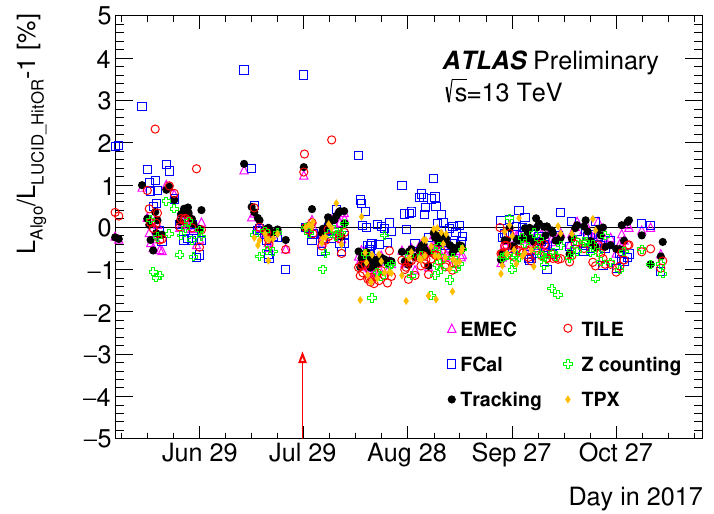
Figure 3. Fractional difference in the run-integrated luminosity between the preferred LUCID algorithm and other detectors as defined in the introduction, in 2017 [7]. The red arrow points to the run chosen as